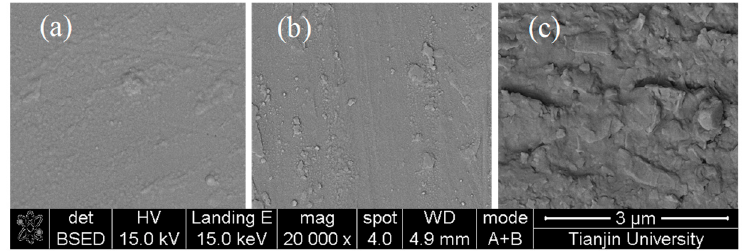
Figure 1. SEM images of surface morphology of epoxy resin samples at different etching times. ( a ), ( b ), ( c ) represent the etching time respectively: 0 min, 5 min, 30 min.